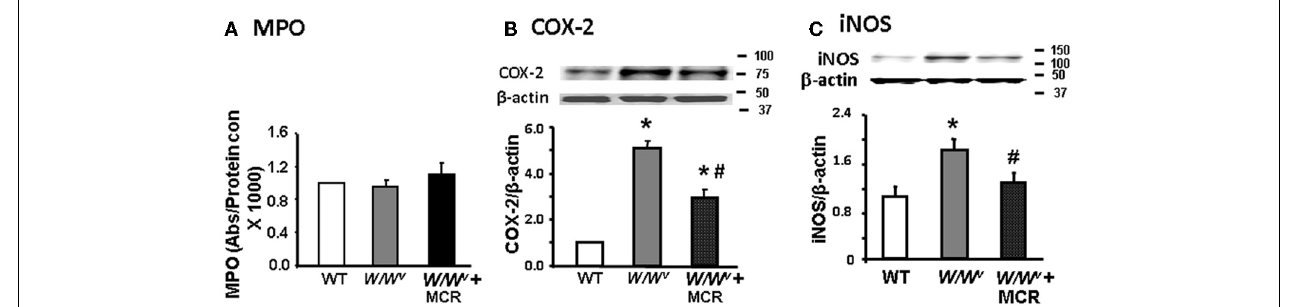
in W/W v mice that was significantly reduced by mast cell reconstitution. (C) Western blot showing a significant increase in iNOS expression in W/W v mice that was significantly reduced by mast cell reconstitution, n = 5, ∗ p < 0 . 05 vs. wild type mice; # p < 0 . 05 vs. W/W v mice.